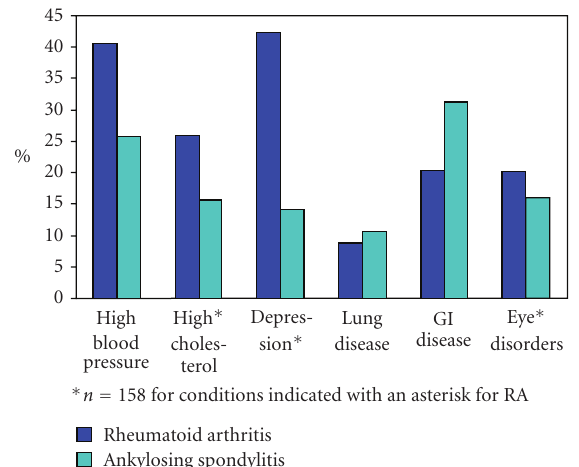
Figure 2: Self-reported comorbidities in ankylosing spondylitis ( n = 198) and rheumatoid arthritis ( N = 624 ∗